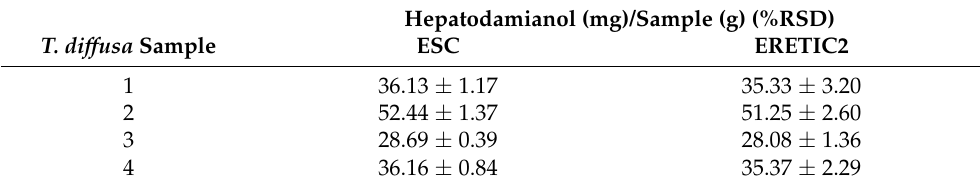
Table 9. Concentration of hepatodamianol in standardized extract samples of T. diffusa determined by ESC and ERETIC2 (based on the PULCON method). Results are given as the average of three measurements ( n =